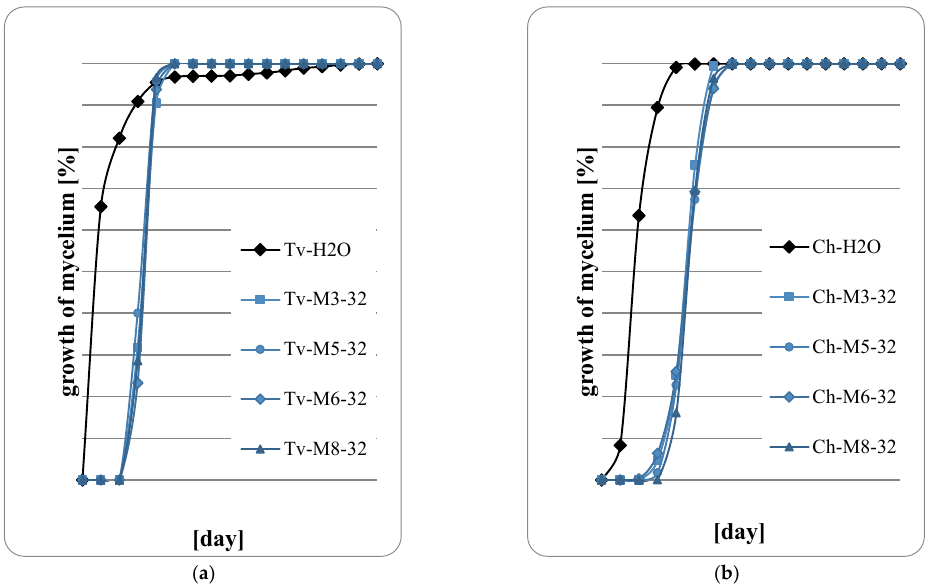
Figure 7. Fungal growth on wood: ( a ) T. viride; ( b ) Ch. globusom ( explanation of symbols in the legend: Ch-H20—control, 32—sample code indicating the application of 800 g of extract per m 2 , M3— M. spicata ‘Morocco’, M5— M. spicata ‘Crispa’, M6— M. × piperita ‘Almira’, M8— M. suaveolens ’ Variegata’).